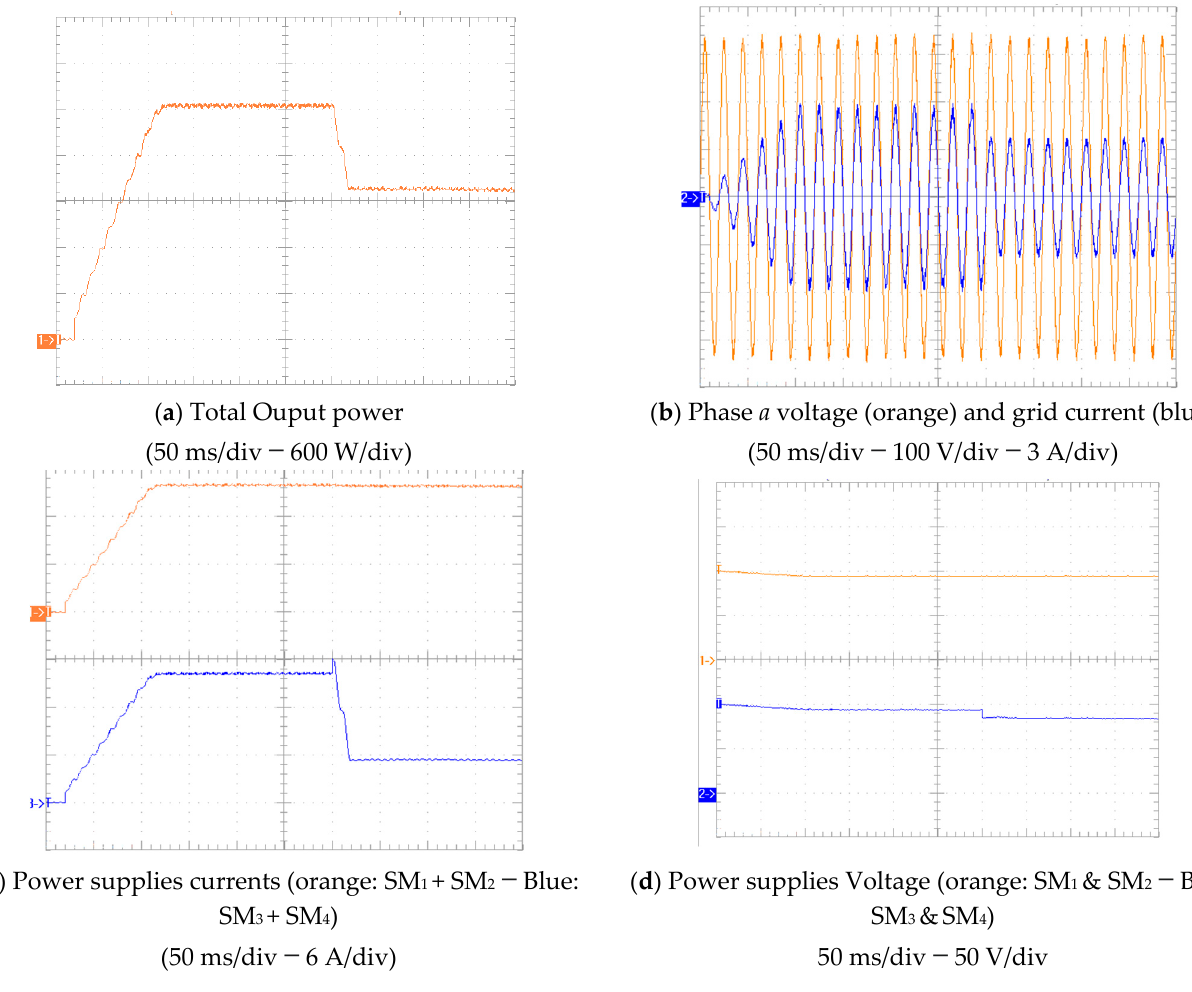
Figure 30. Mode 4 (from PV to grid) experimental results.